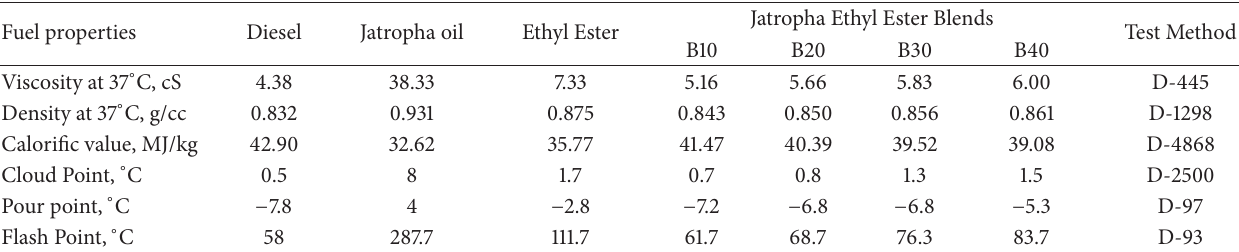
Table 1: Comparison of fuel properties of different